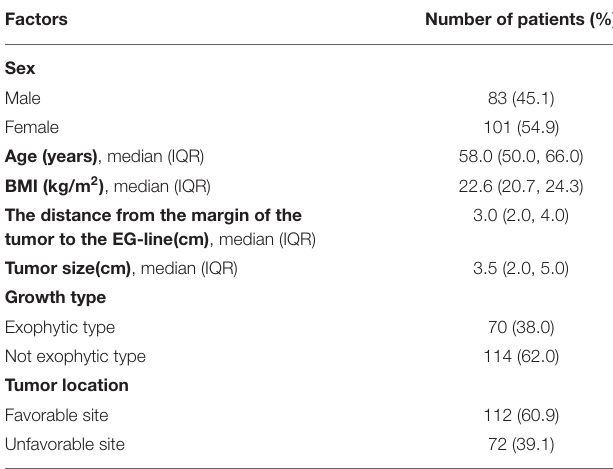
TABLE 1 | Clinical characteristics of 184 patients of EGJ-GISTs undergoing laparoscopic